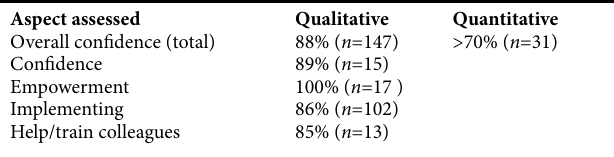
table IV. convergence of results with regard to confidence Aspect